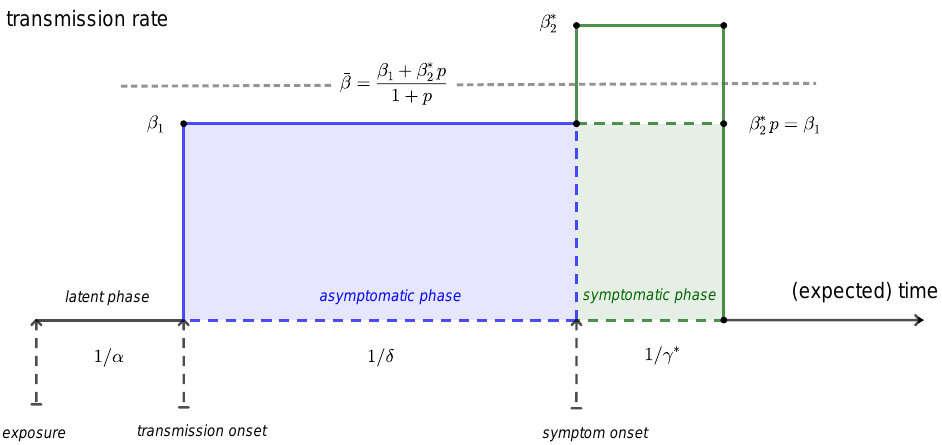
Figure 5. At maximal basic reproduction number, transmission rate is always higher in the symp- > β ∗ p = β 1 , yet most of the infections take place prior to symptom onset if tomatic phase β ∗ 2 2 > 1 longer asymptomatic phase 1 . # of pre-symptomatic infections 62% ( blue area ) and # of post- γ ∗ δ symptomatic infections 38% ( green area) and the sum of both areas is the basic reproduction number R = β 1 + β ∗ 2 p . Parameter values: 1/ δ = 4 days, 1/ γ ∗ = 2.42 days, β 1 / δ = 0.75, p = 0.7, q = 0.2 0, a γ ∗ δ and c = 2.4. No-transmission of the infection on the latent